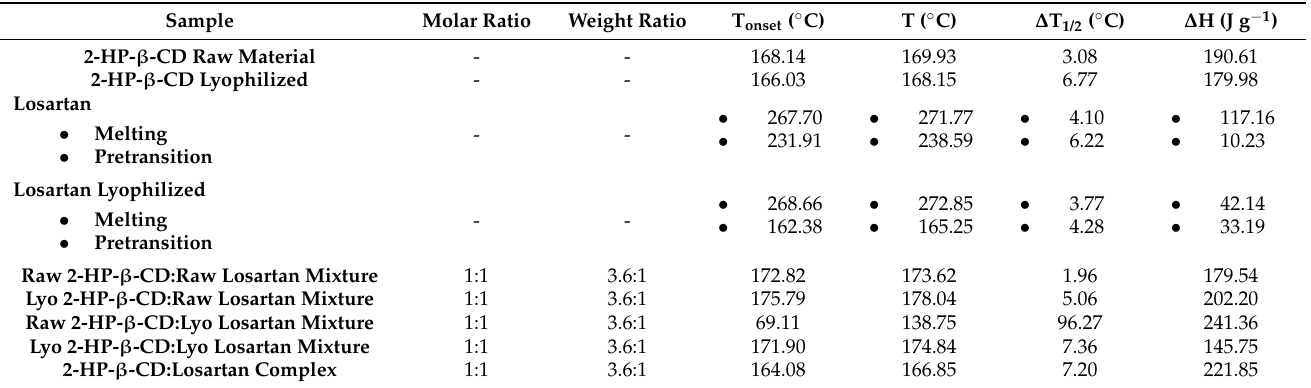
Table 1. DSC thermodynamic parameters of the transition peaks of 2-HP- β -CD and losartan in raw material and lyophilized form, their mixtures and